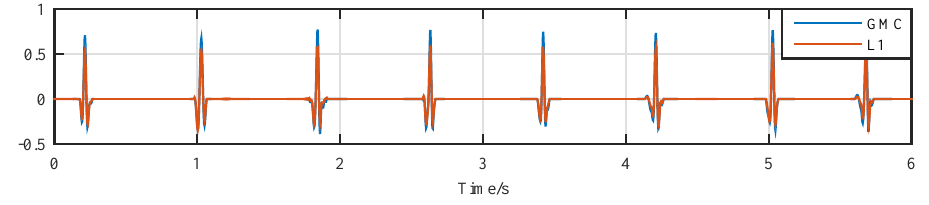
Figure 7. Output of the sparsity recovery